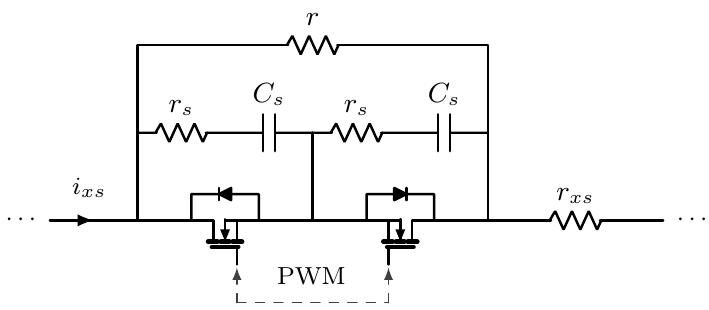
Figure 11. Circuit for achieving a desired average external stator